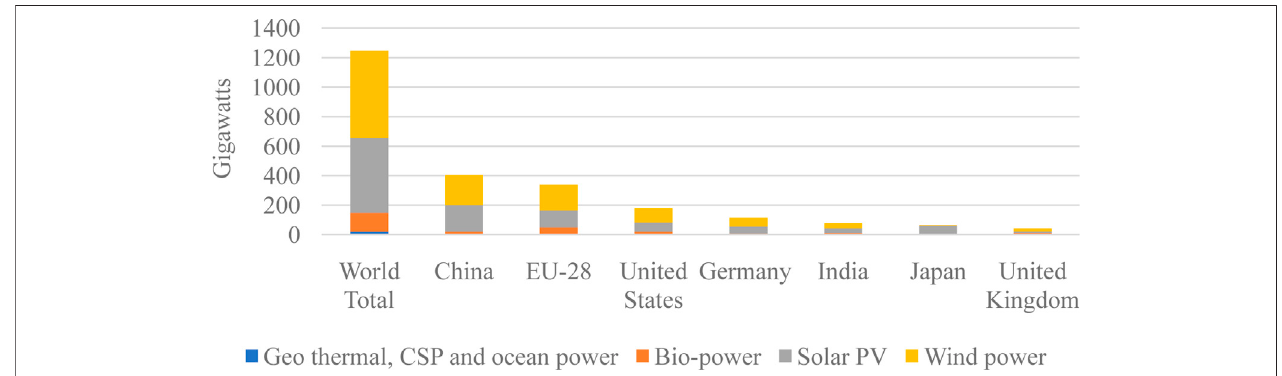
FIGURE 1 | Renewable power capacities in world, EU-28 and top six countries 2018 (Renewable 2018 Global Status Report, 2018).